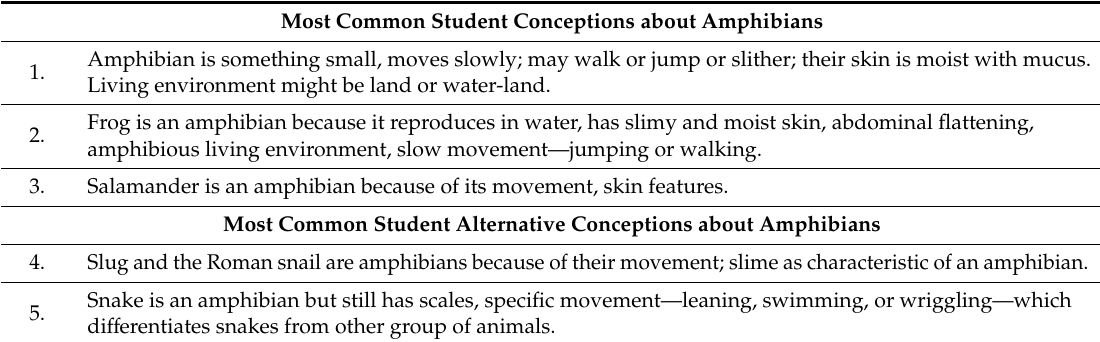
Table 1. Examples of conceptions which arise from answers before intervention about amphibians. Most Common Student Conceptions about Amphibians